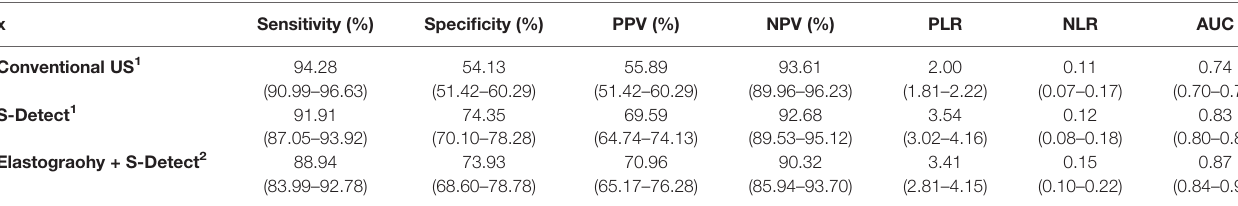
TABLE 2 | The diagnostic performances of S-Detect ™ , conventional US, and combining diagnosis.